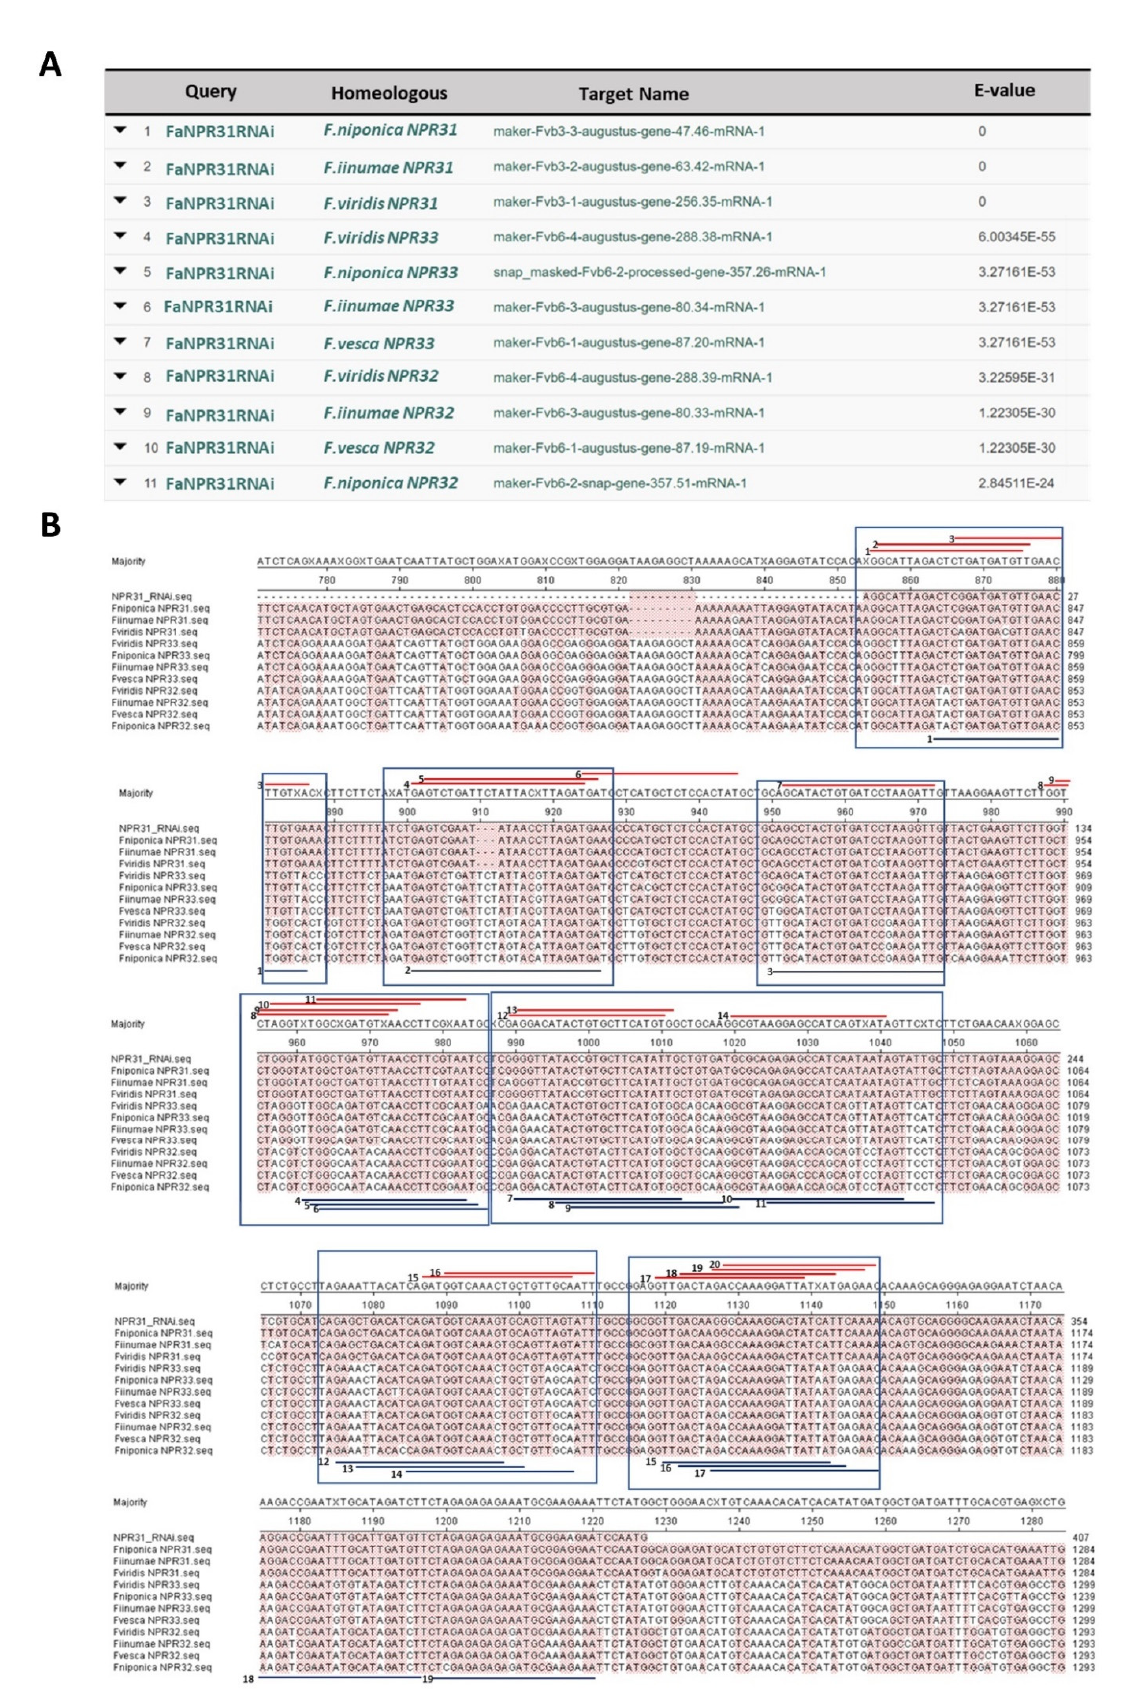
Figure 3. The FaNPR3.1 DNA fragment selected for dsRNAi silencing (FaNPR31RNAi). ( A )